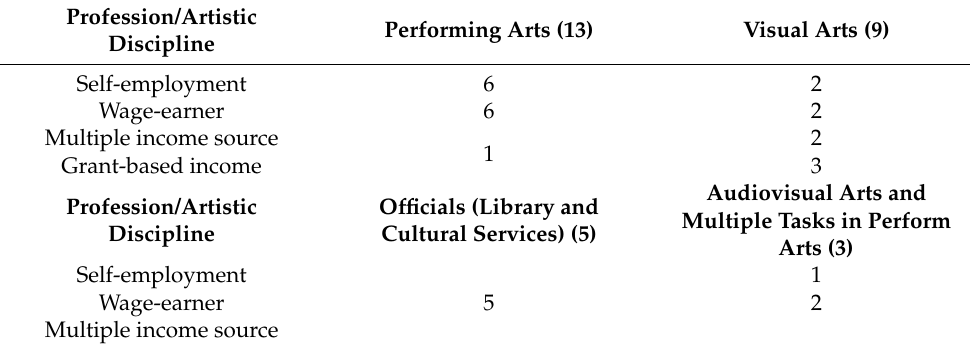
Table 2. The data categorized by profession/artistic discipline and employment